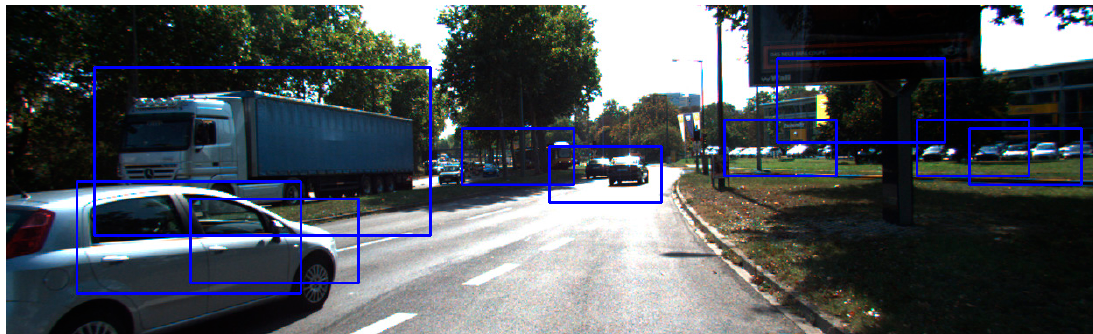
Figure 8. Detection example in the scenario with complex edge information of buildings and background-appearing vehicle-like